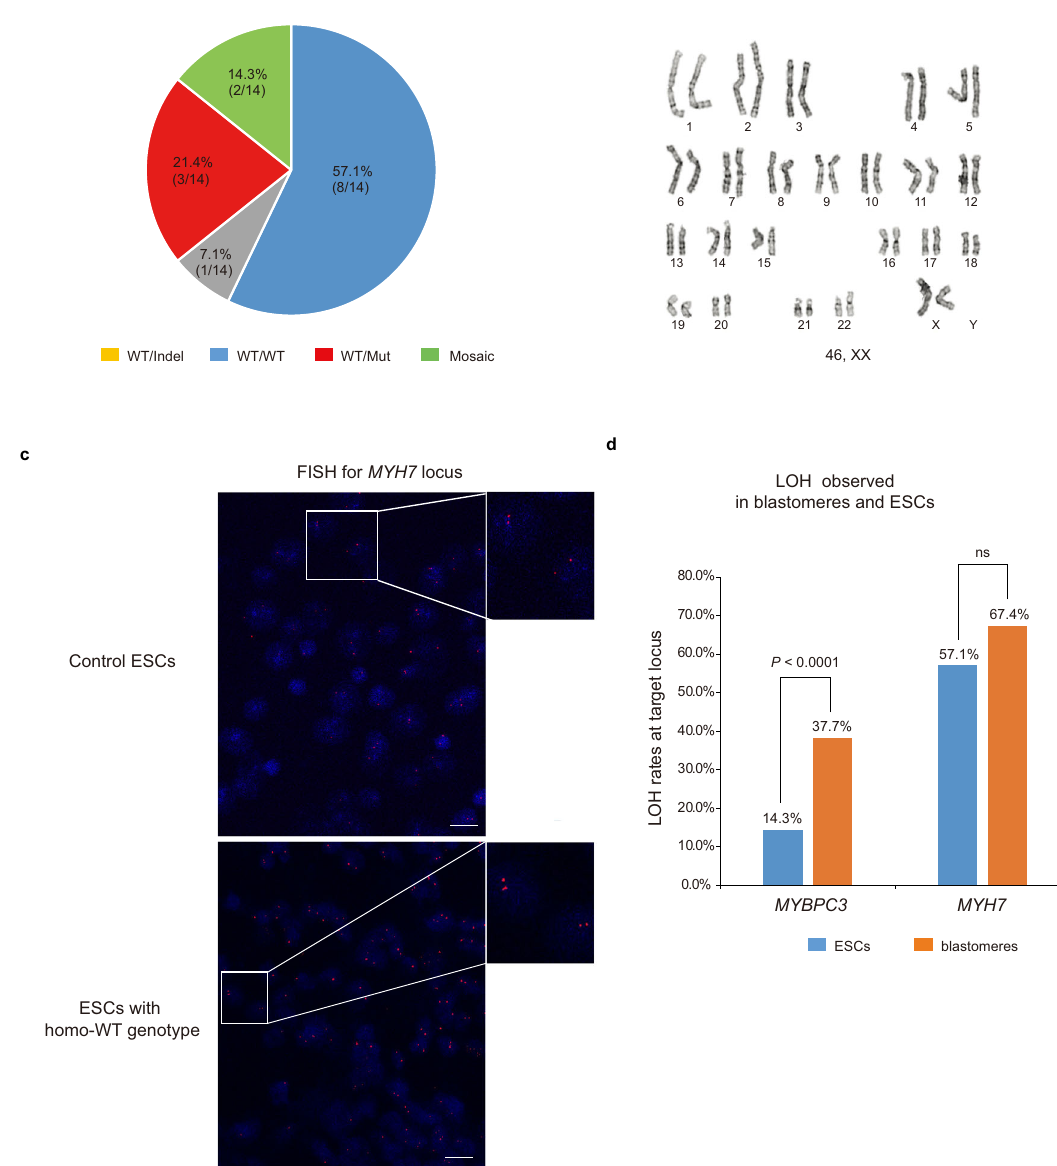
Fig. 4 | Monoallelic DSB repair at the MYH7 locus in ESCs derived from edited human embryos. a MYH7 genotypes in 14 ESC lines derived from CRISPR/Cas9 injectedembryos.Similarto thatseen inblastomeres, a substantial numberofESC lines carried MYH7 homo-WT genotypes. b G-banding analysis of MYH7 homo-WT ESCs derived from injected blastocysts exhibited normal euploid karyotype. c FISH labelingofthe MYH7 locusin MYH7 homo-WT